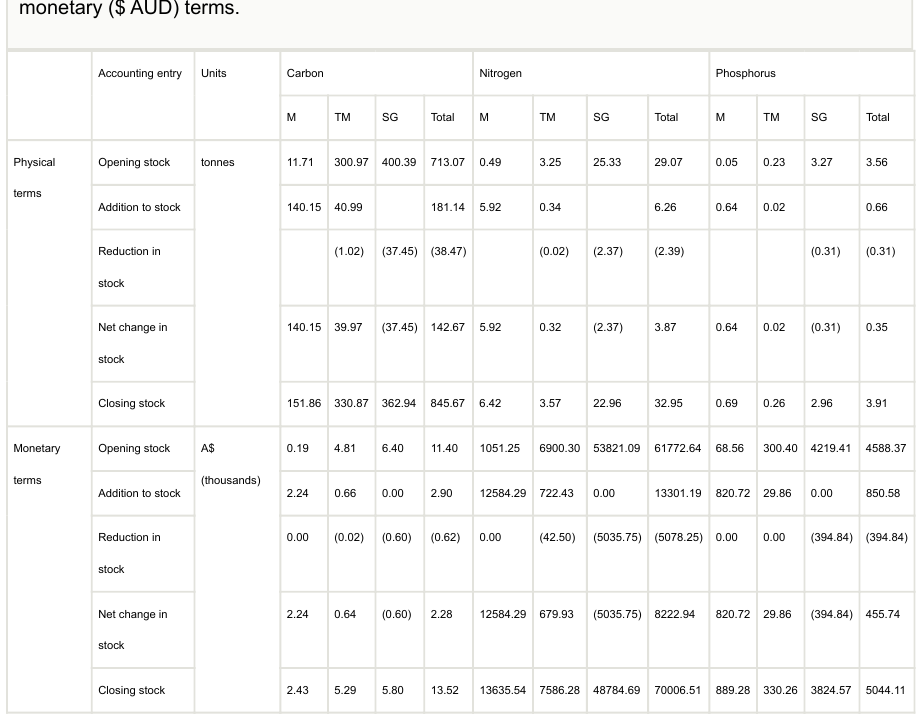
Change in stock of carbon, nitrogen and phosphorus within the biomass of mangrove (M), tidal marsh (TM) and seagrass (SG) ecosystems between 2010 and 2020, in physical (tonnes) and monetary ($ AUD)